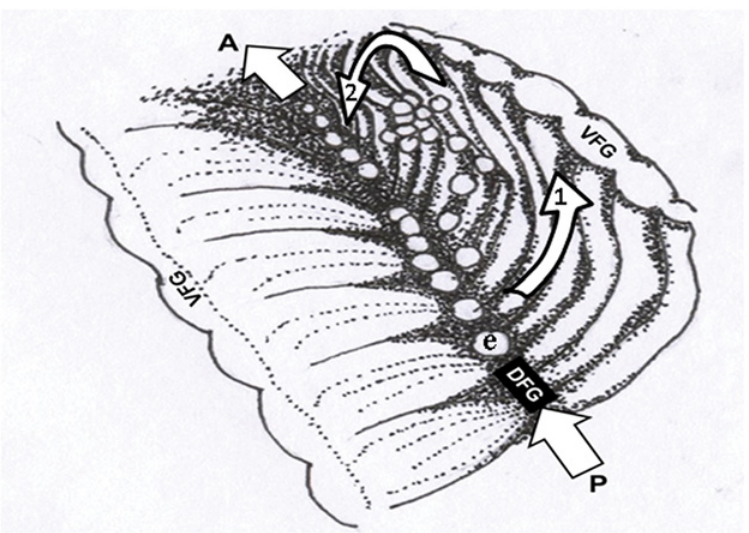
Fig 9. Ostrea chilensis. Schematic of the embryo microcirculation pattern inside the female pallial cavity. 1: embryo movement on the female lamella to VFG, 2: loss of embryo contact with the female gill lamella and their subsequent fall to the DFG. e: embryos, P: posterior female region, A: anterior female region, VFG: ventral food groove, DFG: Dorsal food